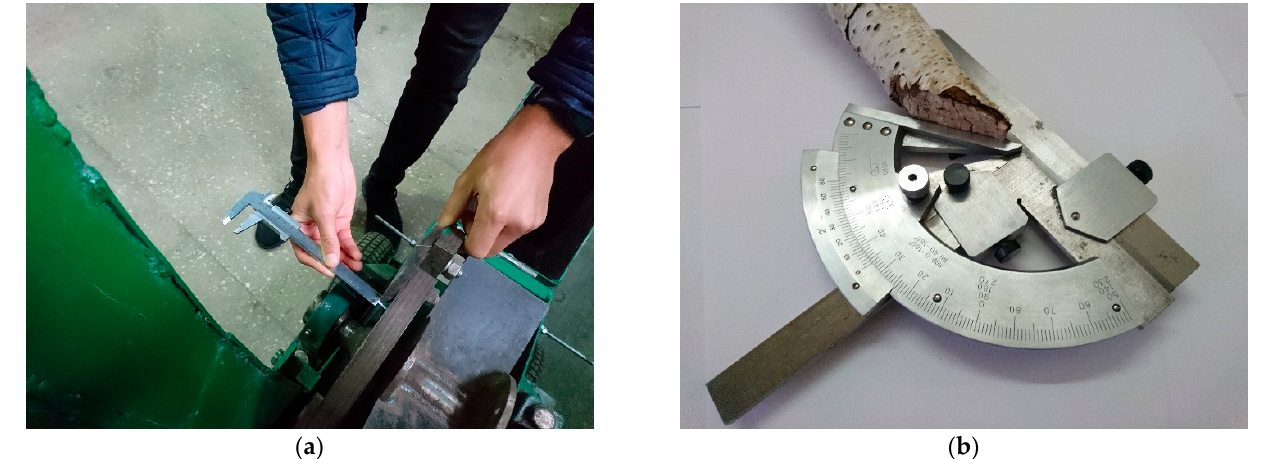
Figure 8. The determination of the optimal values of effecting parameters: ( a ) the measurement of the size of the knife protrusion, ( b ) the measurement of the cutting angle of wood branches.